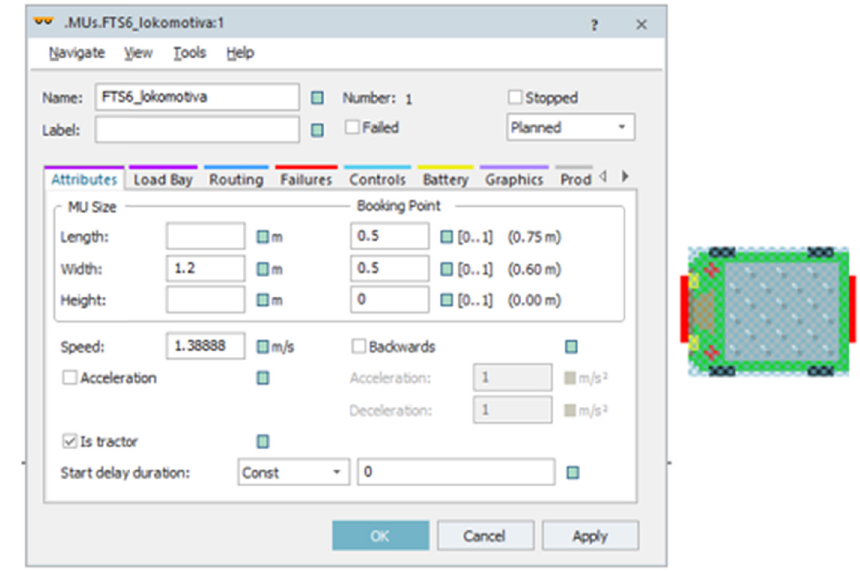
Figure 5: Manipulation unit in the simulation program Tecnomatix Plant